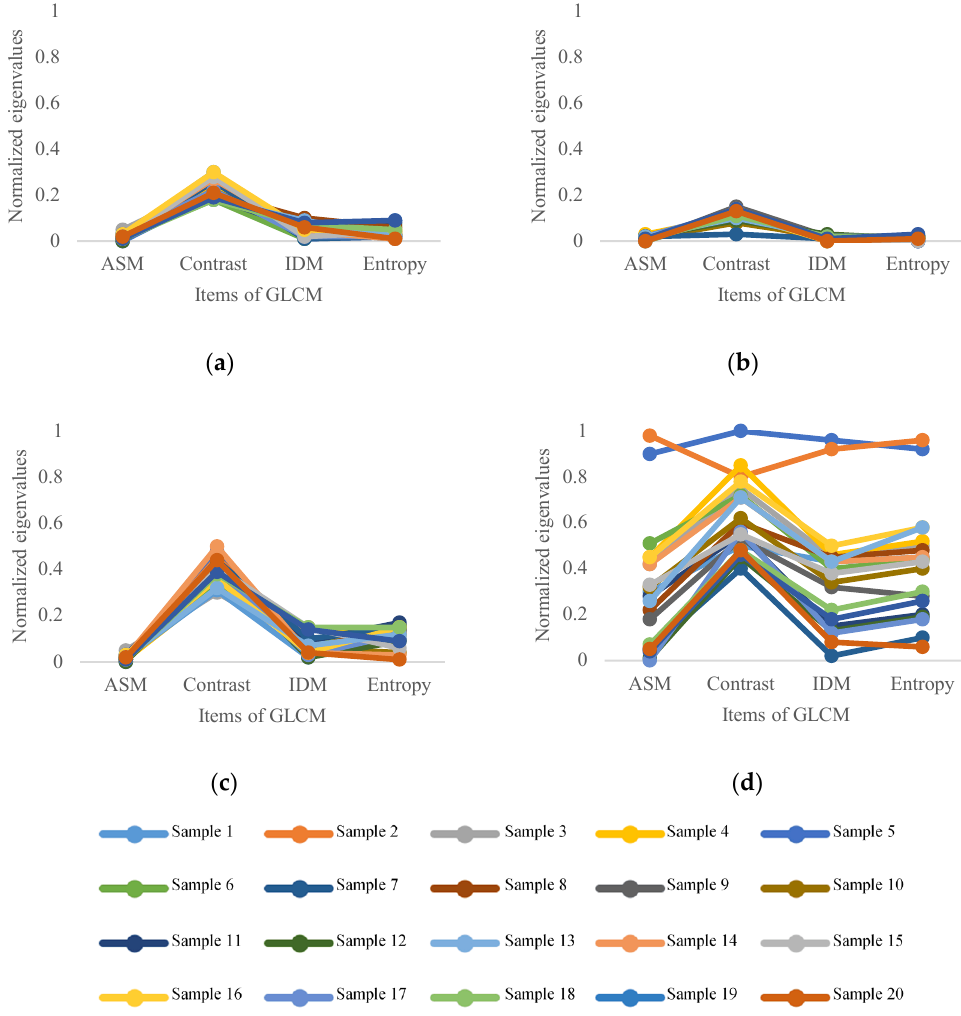
Figure 18. GLCM feature of pear surface defects. ( a ) Stabbed defect. ( b ) Bruised defect. ( c ) Abraded